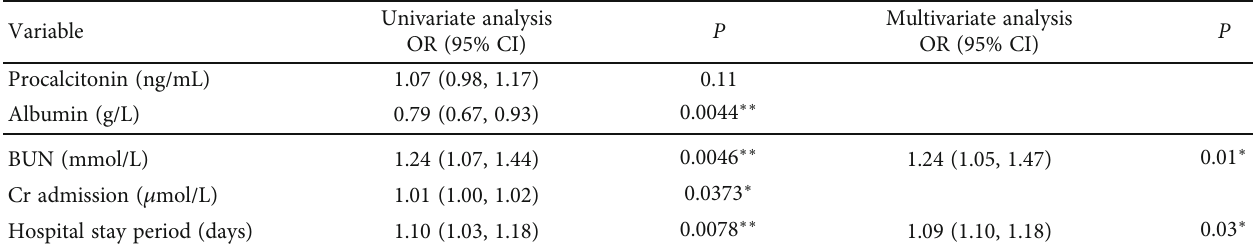
Table 6: Risk factors of clinical information for progression by logistic regression.